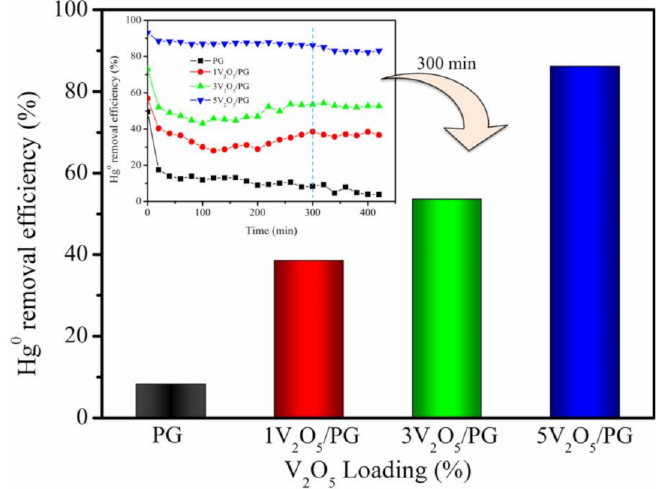
Figure 2. Effect of V 2 O 5 loading on Hg 0 removal (reaction conditions: O 2 = 8%, H 2 O = 5%, SO 2 = 0.15%, N 2 as balance, C Hg 0 = 240 µ g/m 3 , GHSV = 6000 h − 1 , T = 150 ◦